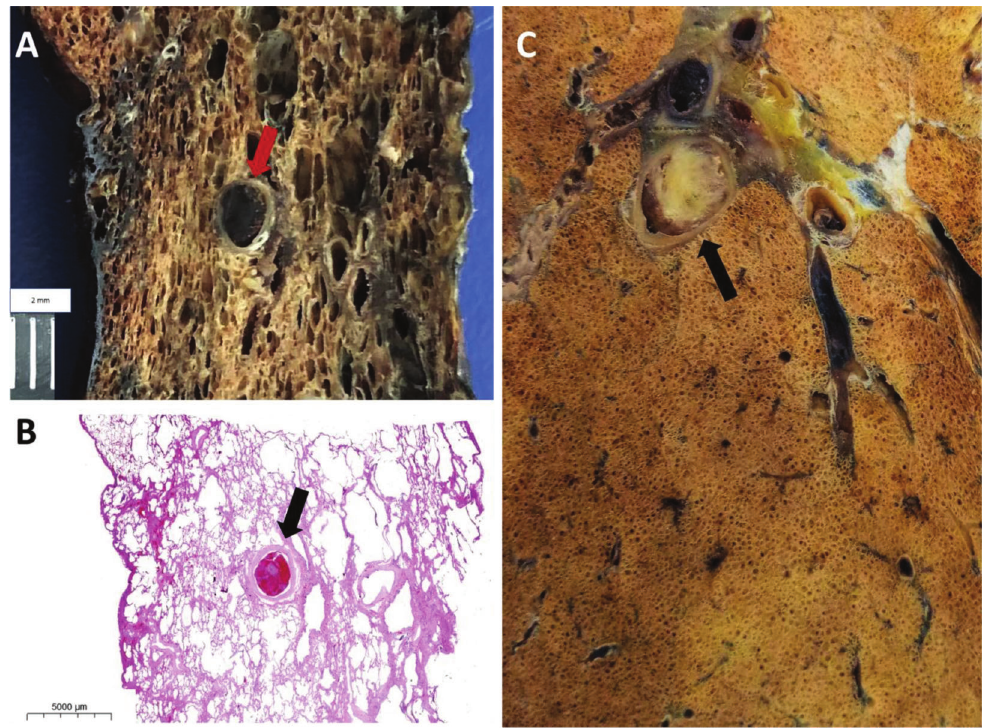
Figure 3 - A and B : Male, 89 years old, 7 days of hospitalization. Gross section (A) and histology (B) of thromboembolism in a medium- sized (3.0 mm in diameter) pulmonary artery (arrow in A and B ). C : Male, 76 years old, 24 days of hospitalization. Same patient as in Figure 2C and 2D . Thromboembolism in a medium-sized (4.0 mm in diameter) pulmonary artery (arrow).